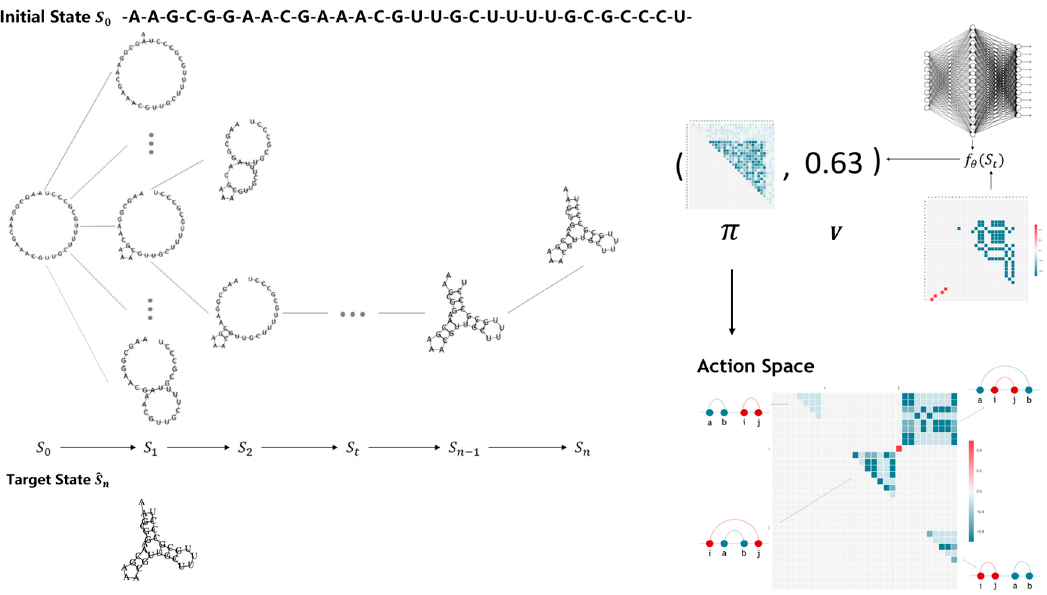
Figure 1. The flow chart of 2dRNA-Fold.